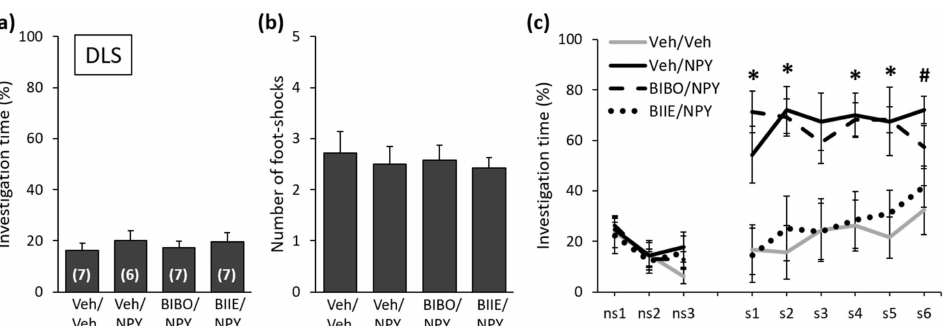
Figure 2. NPY reduces the expression of social fear by acting on Y2 receptors in the dorsolateral septum (DLS). ( a ) Preconditioning investigation of the non-social stimulus (empty cage) during SFC on Day 1. ( b ) Number of foot shocks received during SFC. ( c ) Investigation of the non-social (ns1–ns3) and social (cages with mice; s1–s6) stimuli during social fear extinction on Day 2. Conditioned mice were bilaterally infused with either vehicle (Veh; 0.2 µ L/side), BIBO3304 trifluoroacetate (BIBO; Y1 receptor antagonist; 0.2 nmol/0.2 µ L/side) or BIIE0246 (BIIE; Y2 receptor antagonist; 0.2 nmol/0.2 µ L/side) into the DLS 20 min before social fear extinction on Day 2. After 10 min, mice were infused again with Veh (0.2 µ L/side) or NPY (0.1 nmol/0.2 µ L/side). NPY reduced the expression of social fear; this effect was blocked by BIIE but not by BIBO (treatment effect: F (3,23) = 12.195; p < 0.001; stimulus x treatment effect: F (24,184) = 2.829; p < 0.001). Data represent the means ± SEM, and numbers in parentheses indicate group sizes. p < 0.05 * Veh/NPY and BIBO/NPY vs. Veh/Veh, and Veh/NPY vs. BIIE/NPY; #Veh/NPY vs. Veh/Veh.